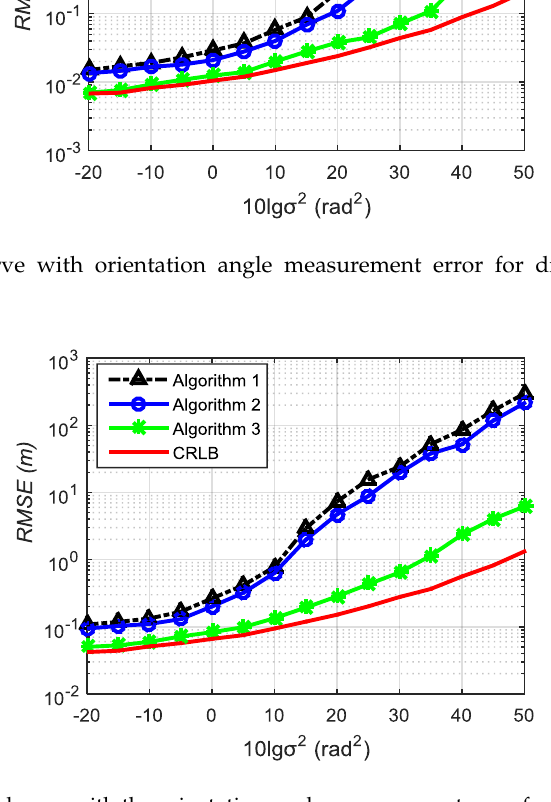
Figure 3. RMSE curve with orientation angle measurement error for different algorithms at SNR = 10 dB.